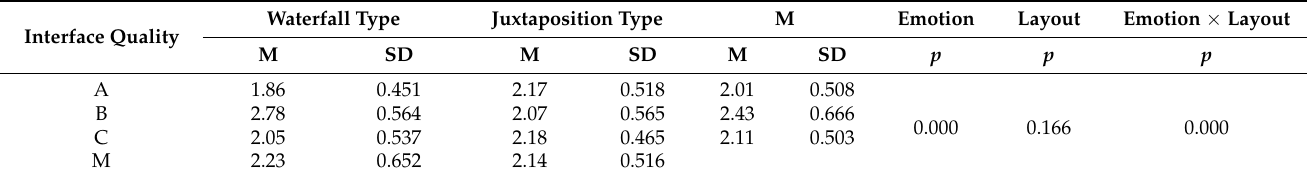
Table 10. Descriptive statistics and two-way ANOVA for interface quality.